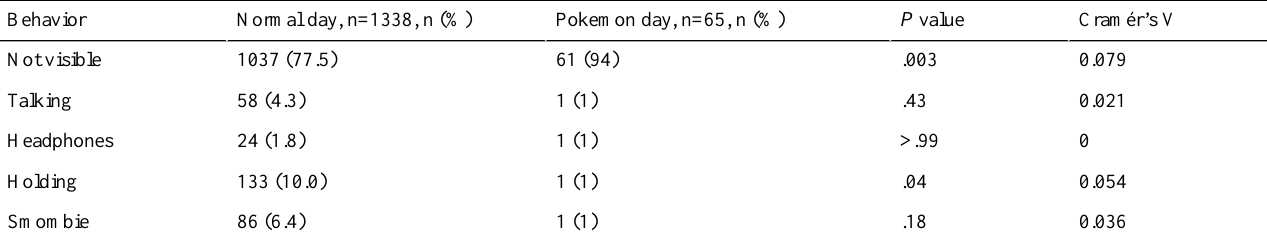
Table 13. Influence of the Pokemon Go Community Day on the smartphone usage behavior in adults (globally P =.04, V=0.085).